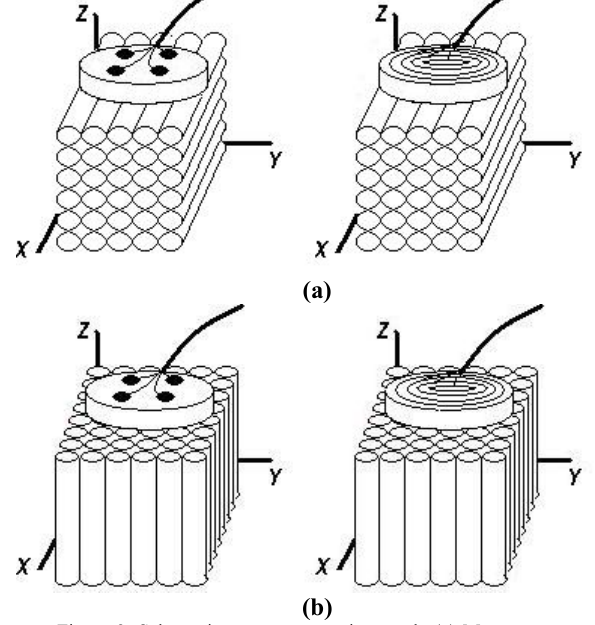
(b) Figure 2: Schematic measurements in muscle (a) Measurements along longitudinal direction of fiber axis with both electrode configurations (b) Measurements in transverse direction with both electrode